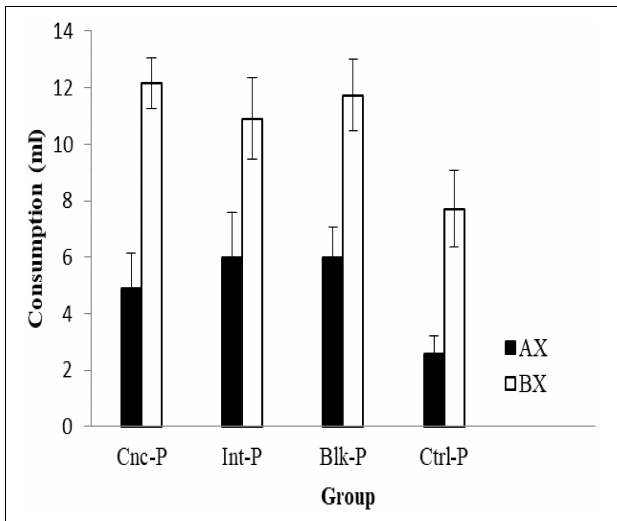
FIGURE 4 | Consumption (ml, mean ± SEM) of the AX and BX solutions during the test trials for the four groups of Experiment